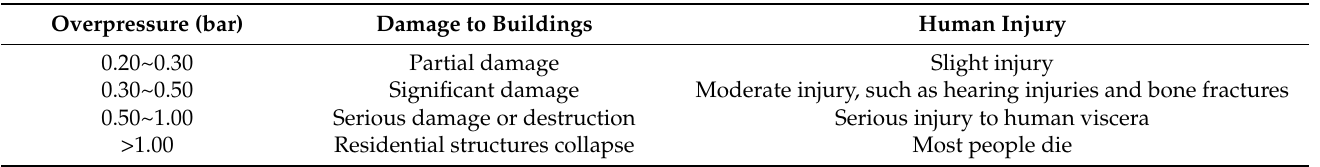
Table 2. Overpressure damages to buildings and humans (Reprinted with permission from Ref.